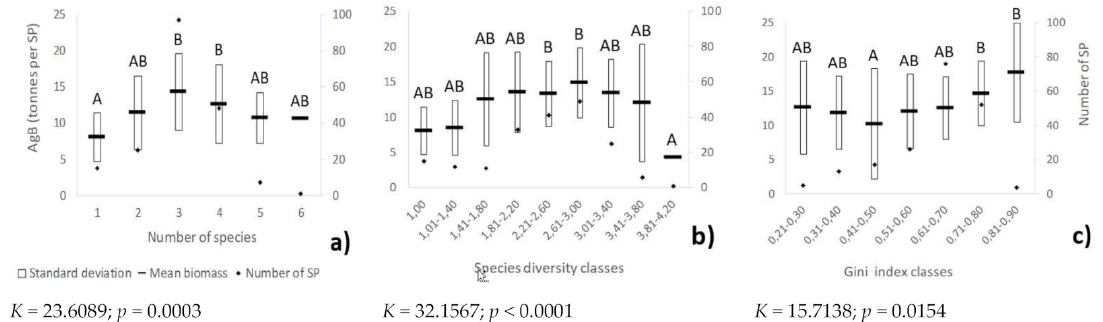
Figure 6. Distribution of aboveground living biomass by tree species richness ( a ), species diversity ( b ) and size heterogeneity ( c ). Different uppercase letters indicate significant differences between classes according to Conover–Iman Multiple pairwise comparisons procedure ( p < 0.05); K represents the Kruskal–Wallis constant, while p indicates the significance level.